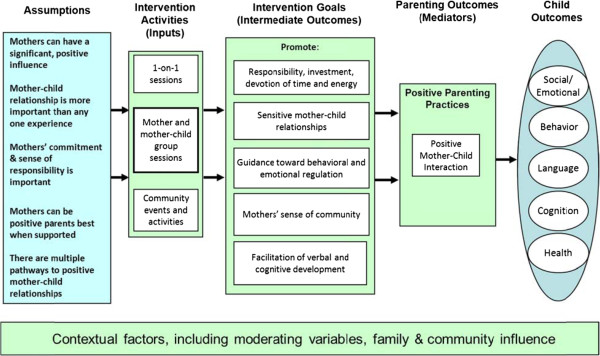
Legacy for ChildrenTM logic model.